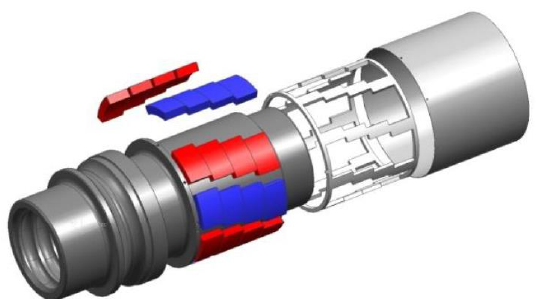
Figure 8. Direct-drive configuration with magnets permanently bonded directly onto the ball-nut.